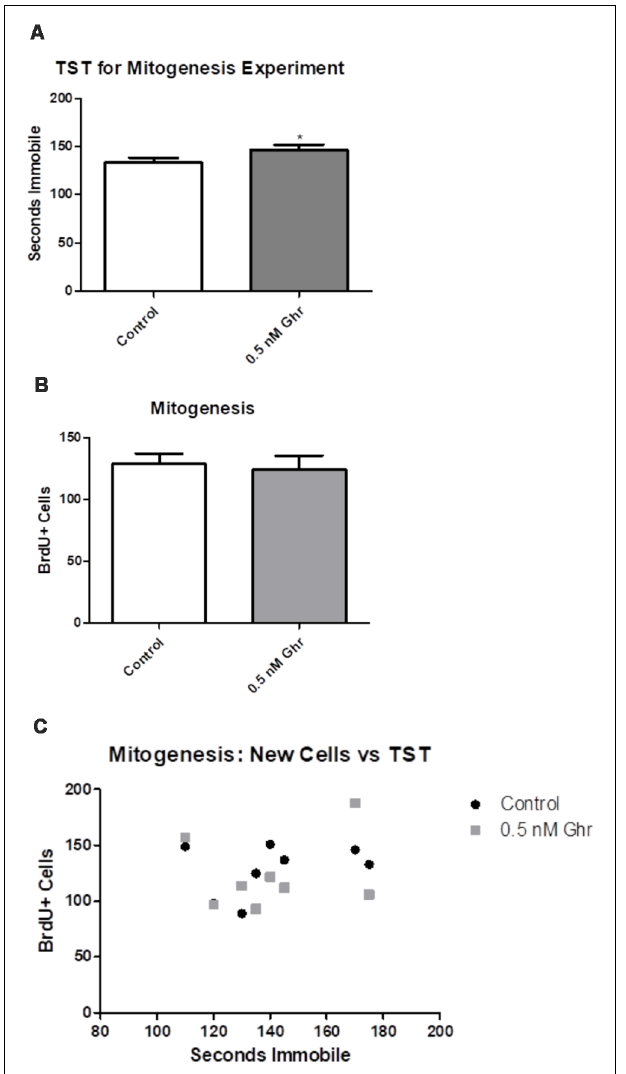
FIGURE 6 | Mitogenesis and the tail suspension test (TST). Behavioral tests as conducted for the mitogenic paradigm. (A) TST for the mitogenic paradigm. Values expressed as mean + SEM ( ∗ p < 0.05). (B) Number of cells that contained BrdU, as quantified using confocal microscopy. Values